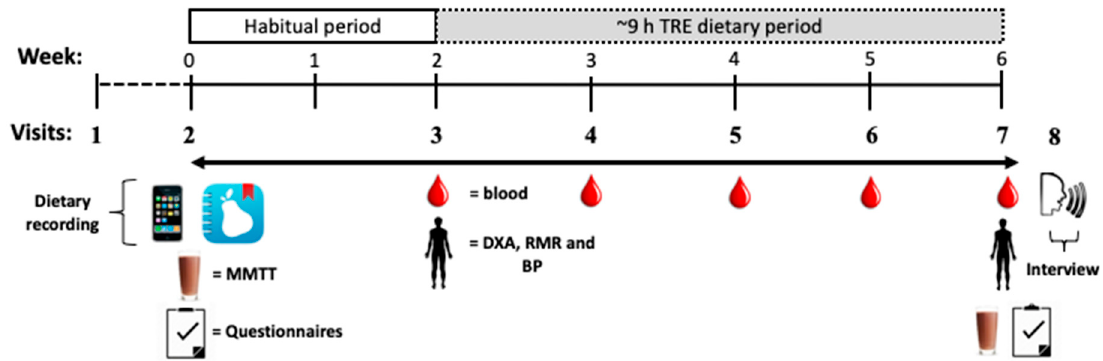
Figure 1. Schematic overview of study protocol. Participants completed a two-week Habitual baseline monitoring period (Week 0–2), immediately followed by a four-week intervention period of time- restricted eating (TRE; Week 2–6; consuming energy within 10:00 and 19:00 h on as many days of the week as possible) with weekly visits to the research team. Dietary recordings were collected